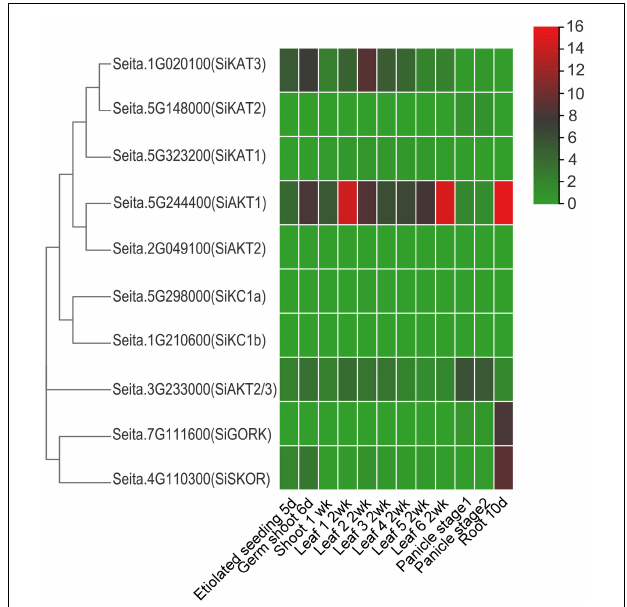
FIGURE 3 | Expression profile of Shaker K + channel genes in different tissues and developmental stages of foxtail millet. Gene expression data is downloaded from the GeneAtlas v1 Tissue Sample (Phytozome 13), including etiolated seeding (5 days), germ shoot (6 days), shoot (1 week), leaf (different leaf at 2 weeks), panicle stage 1 and 2, and root (10 days). The color scale represents expression levels (FPKM value) from high (red) to low (green color).